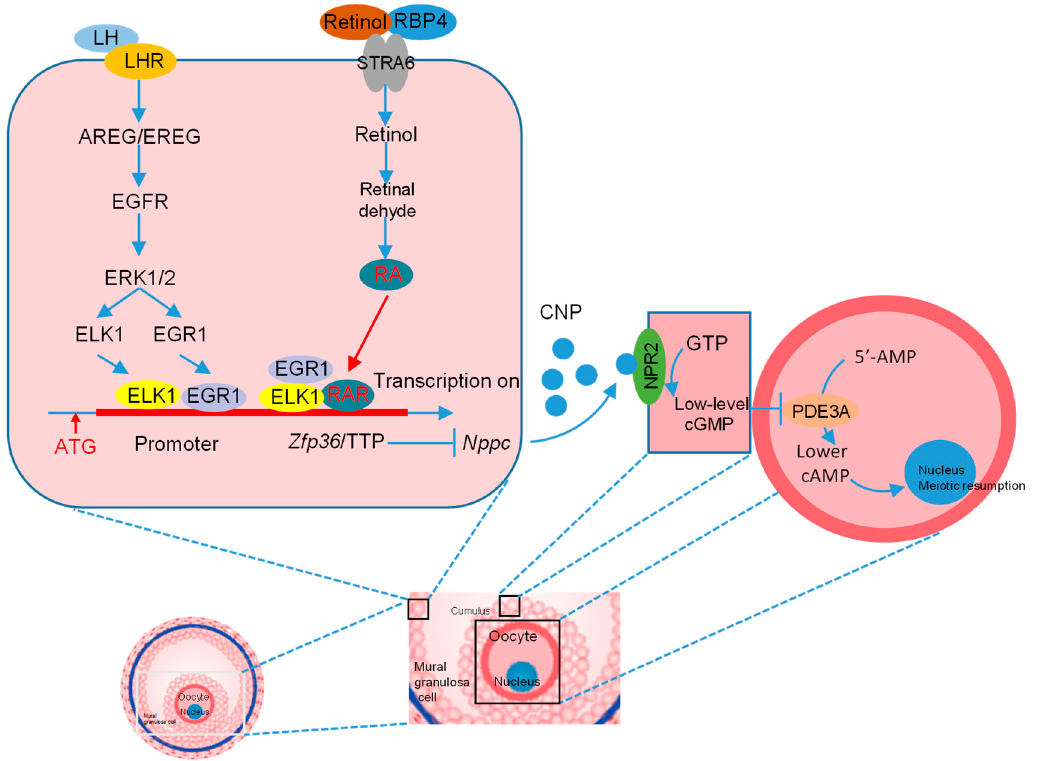
Figure 7. Working model illustrating the mechanism that underlies the role of RA in regulating LH- induced oocyte meiotic resumption. The left indicates the previously reported pathway responsible for Zfp36 upregulation, and the right indicates the pathway identified in the present study.